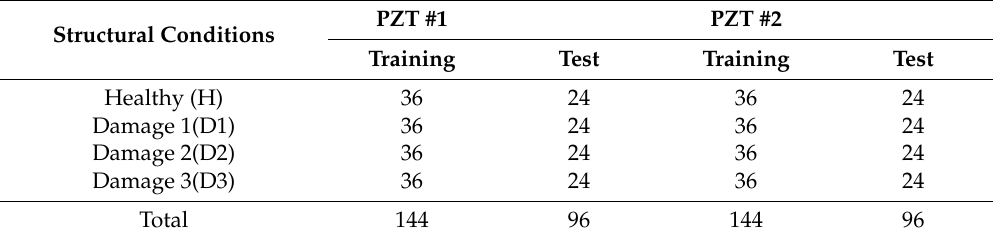
Table 1. Distribution of number of frames, formed from the PZT-EMI signals for PZTs #1 and #2, into the dataset.